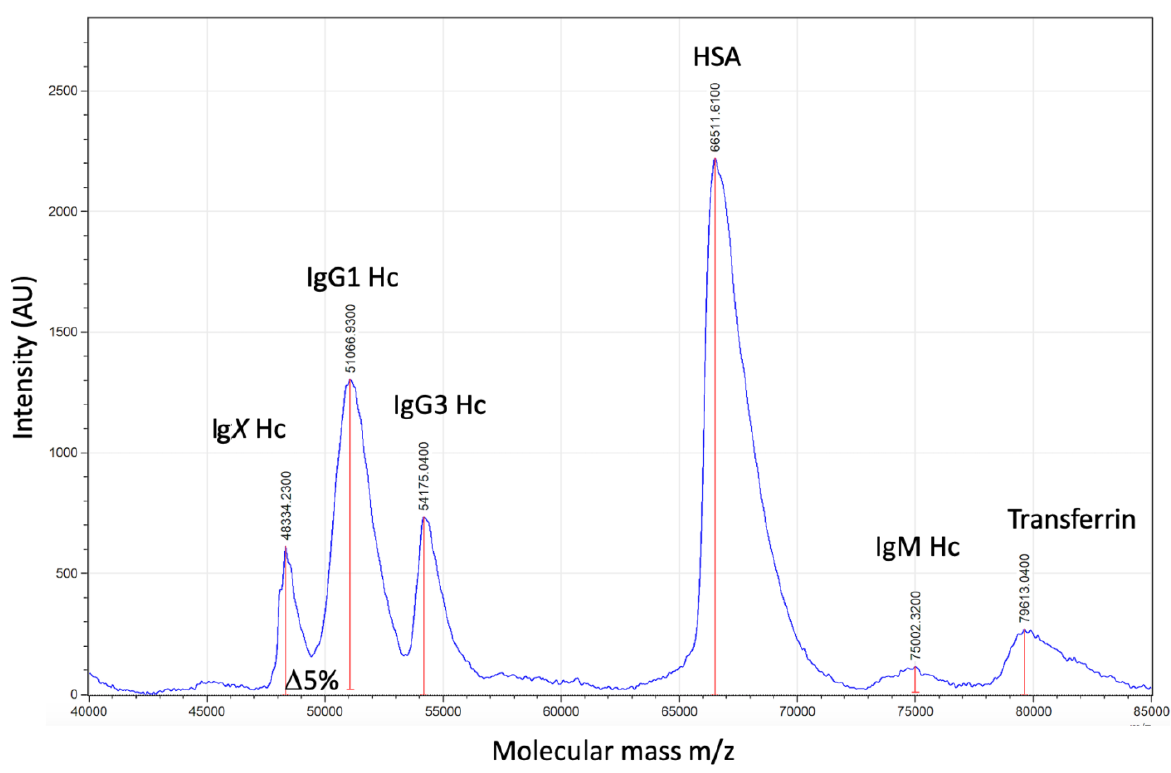
Figure 1. Mass spectra profile, 40,000 m / z to 85,000 m / z , of human reduced plasma samples (treated with Tris(2-carboxyethyl)phosphine (TCEP)) in order to reveal immunoglobulin heavy chains (IgM Hc ‘ 75,000 m / z , IgA ~56,000 m / z not found, IgG3 54,000 m / z and unconfirmed IgX, thought to be IgG4 Hc, at 48,000 m / z . HSA resolved at 66,4000+ m / z and transferrin at 79,000 m / z .